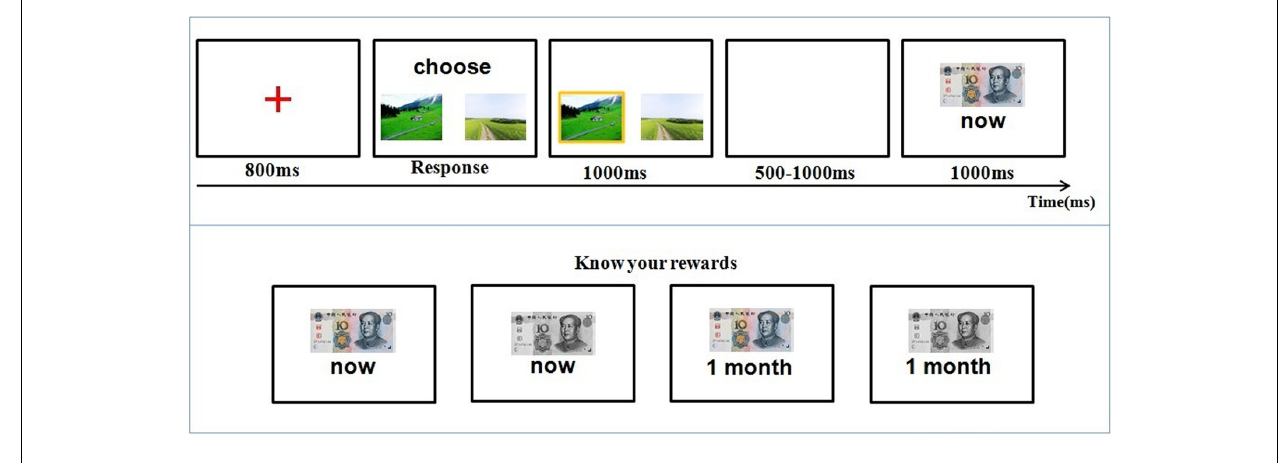
month later (bottom panel).They then chose one of two cards by pressing the corresponding button. At the end of each trial, participants were informed about their outcome (top